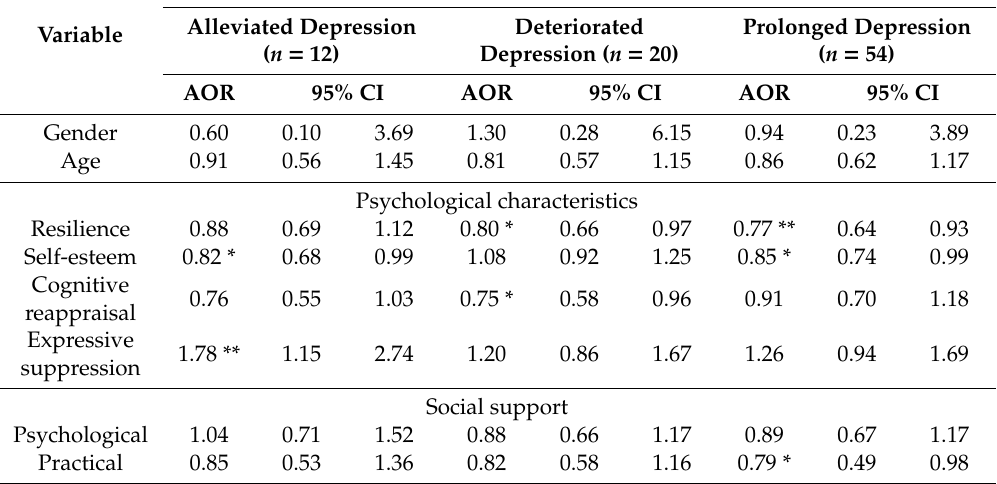
Table 2. The e ff ects of the sociodemographic and psychological factors on change in depression; adjusted odds ratios (AOR) and 95% Confidence Intervals (CI). Depression Change (Ref: Stable Low Depression, n = 20) Alleviated Depression Variable ( n = 12)